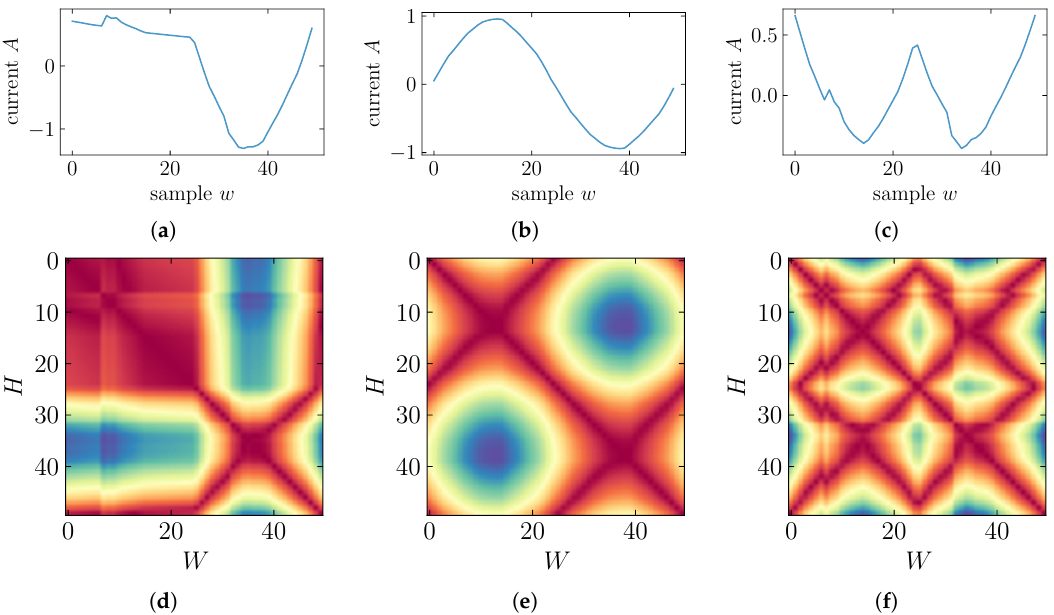
Figure 5. Currents and distance matrix when Compact Fluorescent Lamp (CFL) and laptop charger are active. ( a ) Source current i ( t ) . ( b ) Active current i a ( t ) . ( c ) Non-active current i a ( t ) . ( d ) Distance matrix for source current. ( e ) Distance matrix for active current ( f ) Distance matrix for non-active